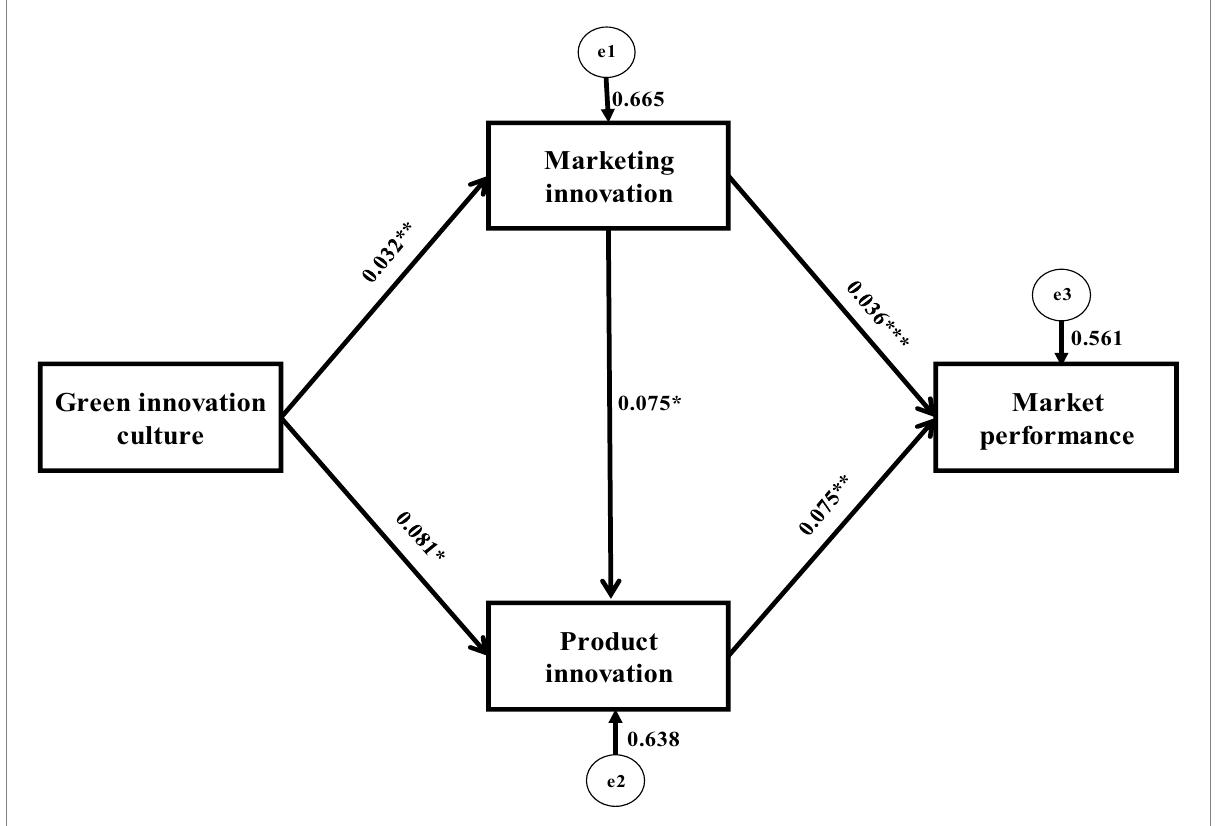
FIGURE 2 Path diagram of structural equation modeling. *** p < 0.01, ** p < 0.05, * p <